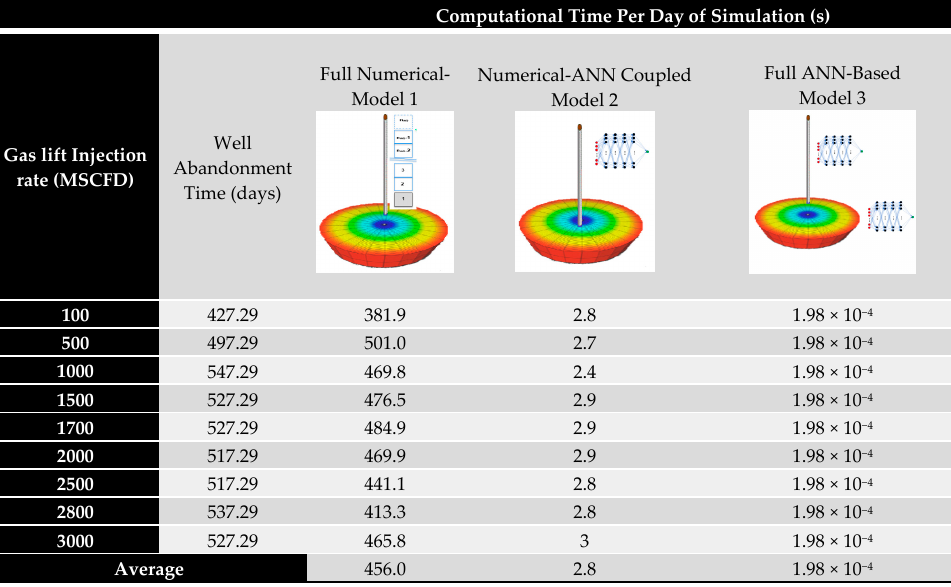
Table 6. Computational time comparison between three different gas lift models.